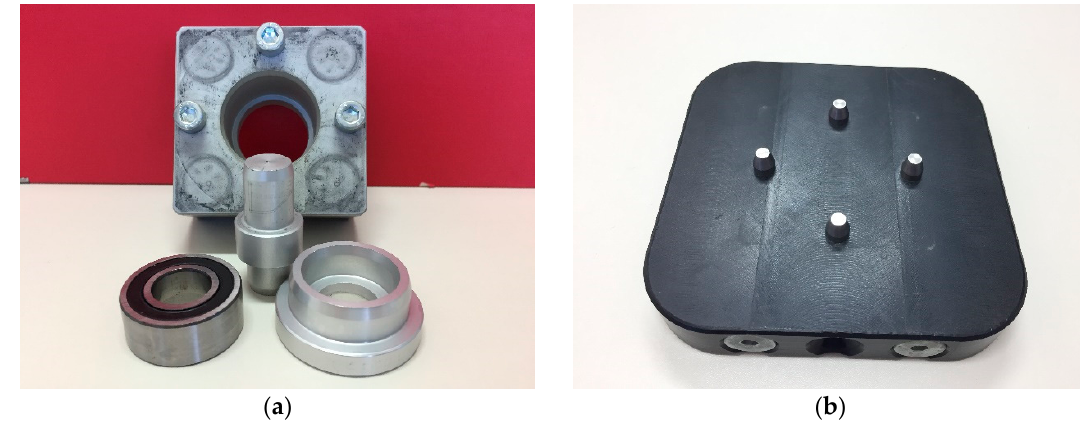
Figure 1. Detail of pieces managed in the FMS: ( a ) Constituent elements of the turning mechanism; ( b ) Transport pallet.